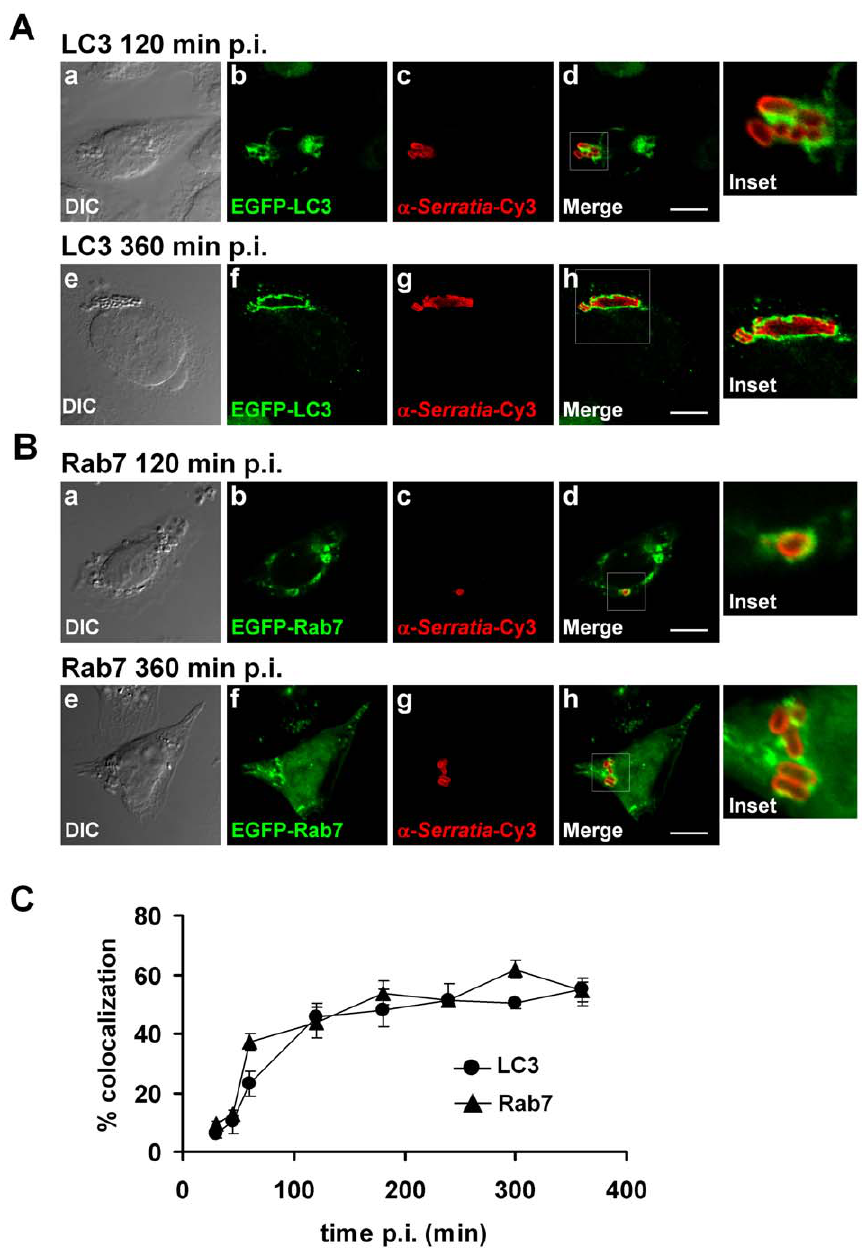
Figure 2. LC3 and Rab7 are recruited to the S.marcescens -containing vacuole. A ) CHO-EGFP-LC3 cells (green fluorescence) or B ) CHO cells transfected with EGFP-Rab7 (green fluorescence), were infected with wild-type S. marcescens and cells were fixed at 120 min p.i (a-d) or 360 minutes p.i (e-h). Bacteria were detected with antibodies anti- Serratia coupled with a secondary antibody labeled with Cy3 (red fluorescence). Representative confocal Z-slices are shown. Inset images show higher magnification of the boxed areas in merged images. Bars: 10 m m. C) CHO-EGFP-LC3 cells or CHO cells transfected with pEGFP-Rab7 were infected with wild-type S. marcescens . Cells were fixed at the indicated time points and bacteria were detected with antibodies anti- Serratia coupled with a secondary antibody labeled with Cy3. The percentage of colocalization of EGFP-LC3 ( EGFP-Rab7 ( m ) with bacteria was determined by fluorescence microscopy. At least 200 infected cells were counted for each time point. The average 6 S.D. for three independent experiments is